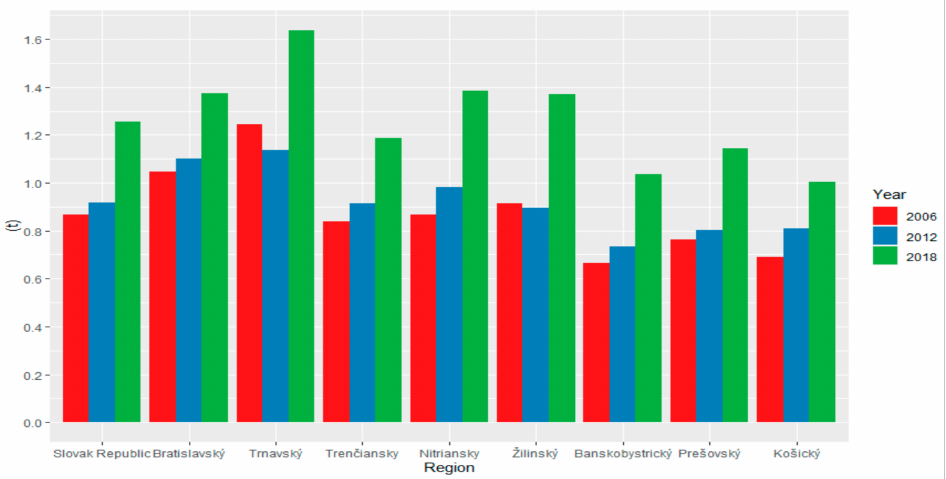
Figure 1. Productivity of communal waste in Slovakian regions.